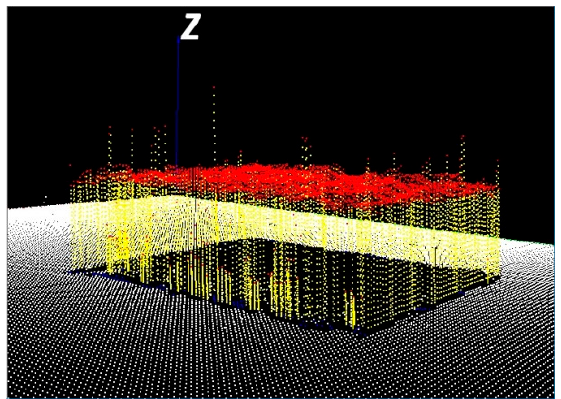
Figure 1. Depth image of a square box with four line edges detected using the traditional Digital image correlation (DIC) method.